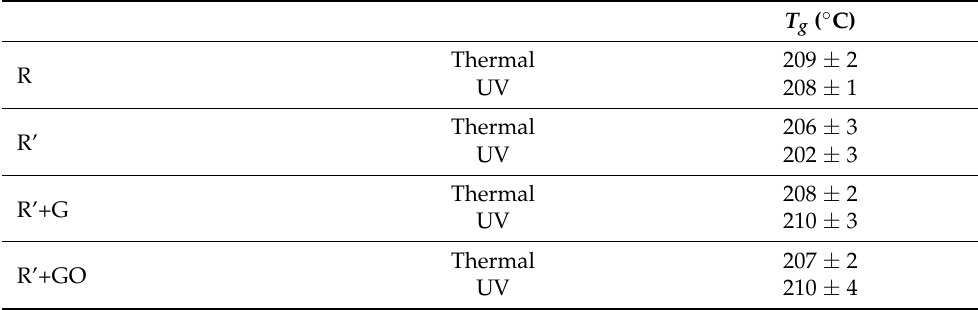
Table 11. Glass transition temperature of samples with thermally and UV-triggered